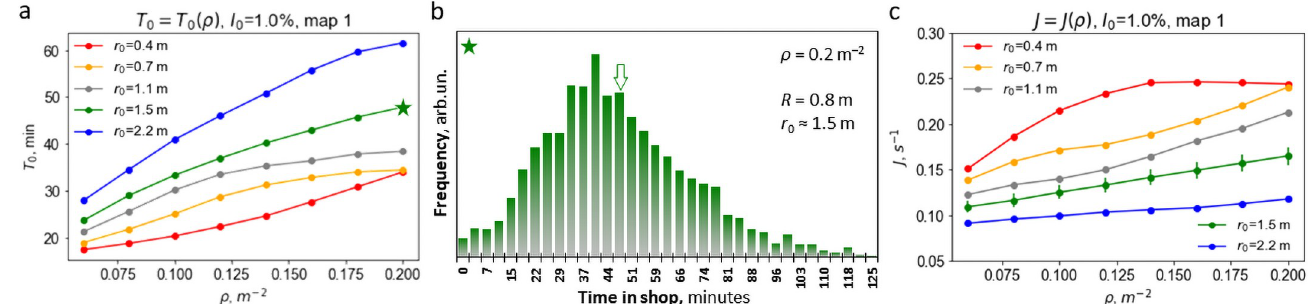
Fig 4. The average time T 0 , spent by a customer in the supermarket. (a) T 0 as a function of density ρ for different social distances r 0 . The star indicates the parameters corresponding to the distribution of average times in panel (b). (b) Distribution of a time spent in the supermarket for ρ = 0.2 m − 2 , r 0 ’ 1.5 m; the arrow indicates the mean time T 0 . (c) The average customer flux J as a function of the customer density ρ for different social distances r 0 . Error bars for r 0 = 1.5 m illustrate the typical accuracy for J .